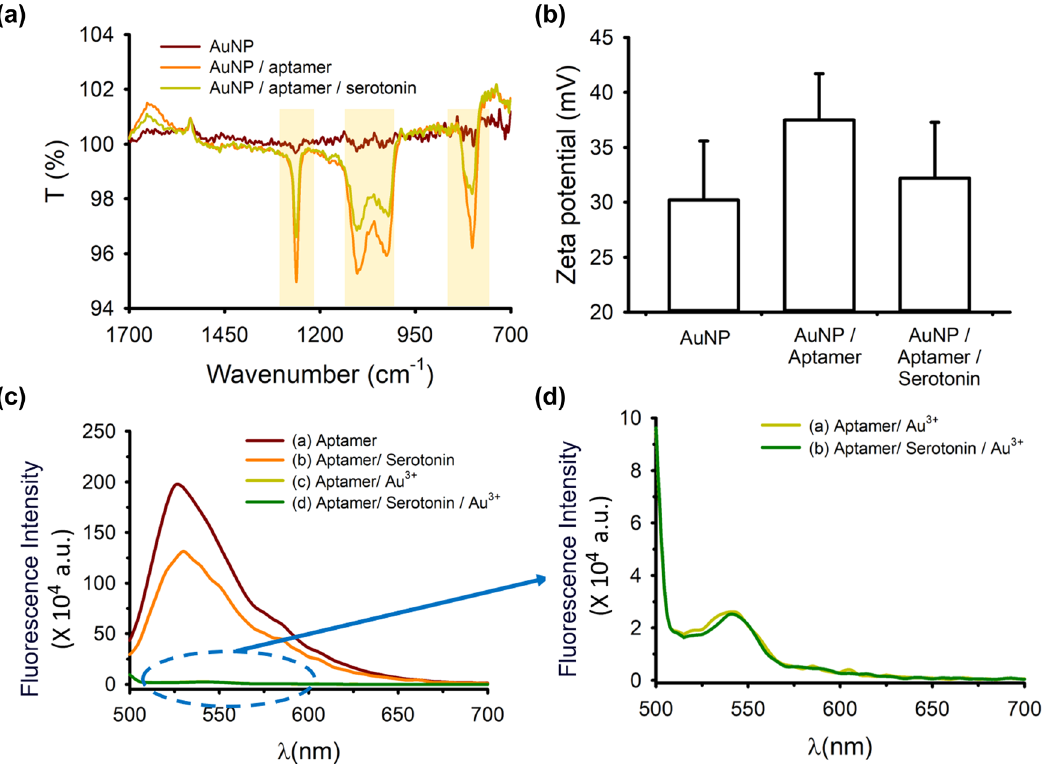
Figure 2: ( a ) FTIR and ( b ) zeta potential responses of synthesized AuNPs only, AuNPs with DNA aptamer, and AuNPs with DNA aptamer and serotonin. The fi nal concentrations of aptamer, serotonin, and NaCl were 20 nM, 10 ng/mL, and 32 mM, respectively. ( c ) Fluorescence spectra of the Oligreen with aptamer only, aptamer/serotonin complex, aptamer and gold ion, and aptamer/serotonin complex and gold ion. ( d ) Magni fi ed view of the fl uorescence spectra of the Oligreen with aptamer and gold ion, and aptamer/serotonin complex and gold ion. The error bars represent the standard deviation of the mean of three measurements ( For the representation of the curves in this fi gure in color, the reader is referred to view the web version of this article. )